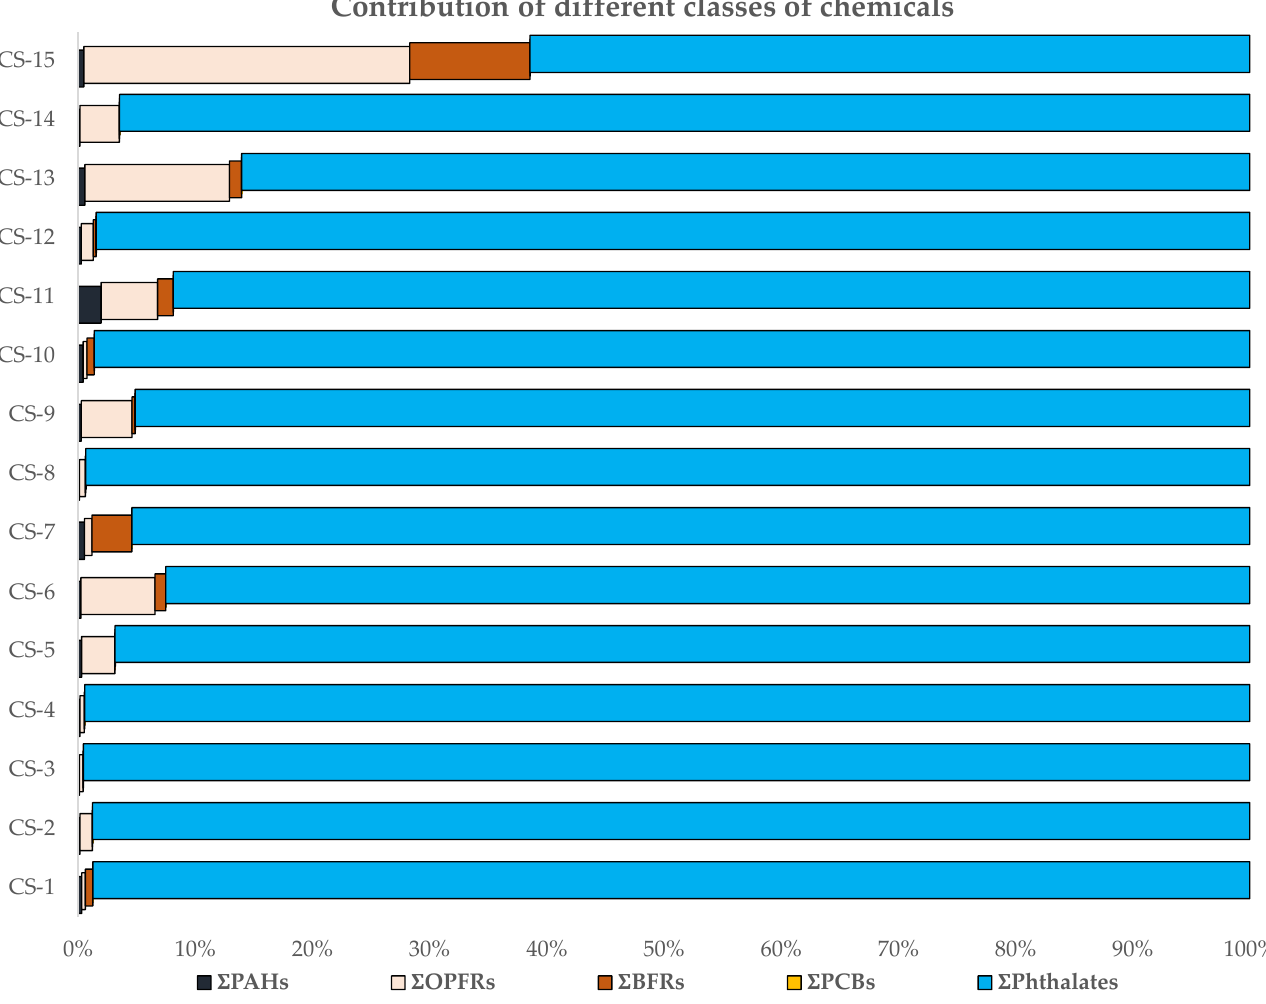
Int. J. Environ. Res. Public Health 2021 , 18 , x